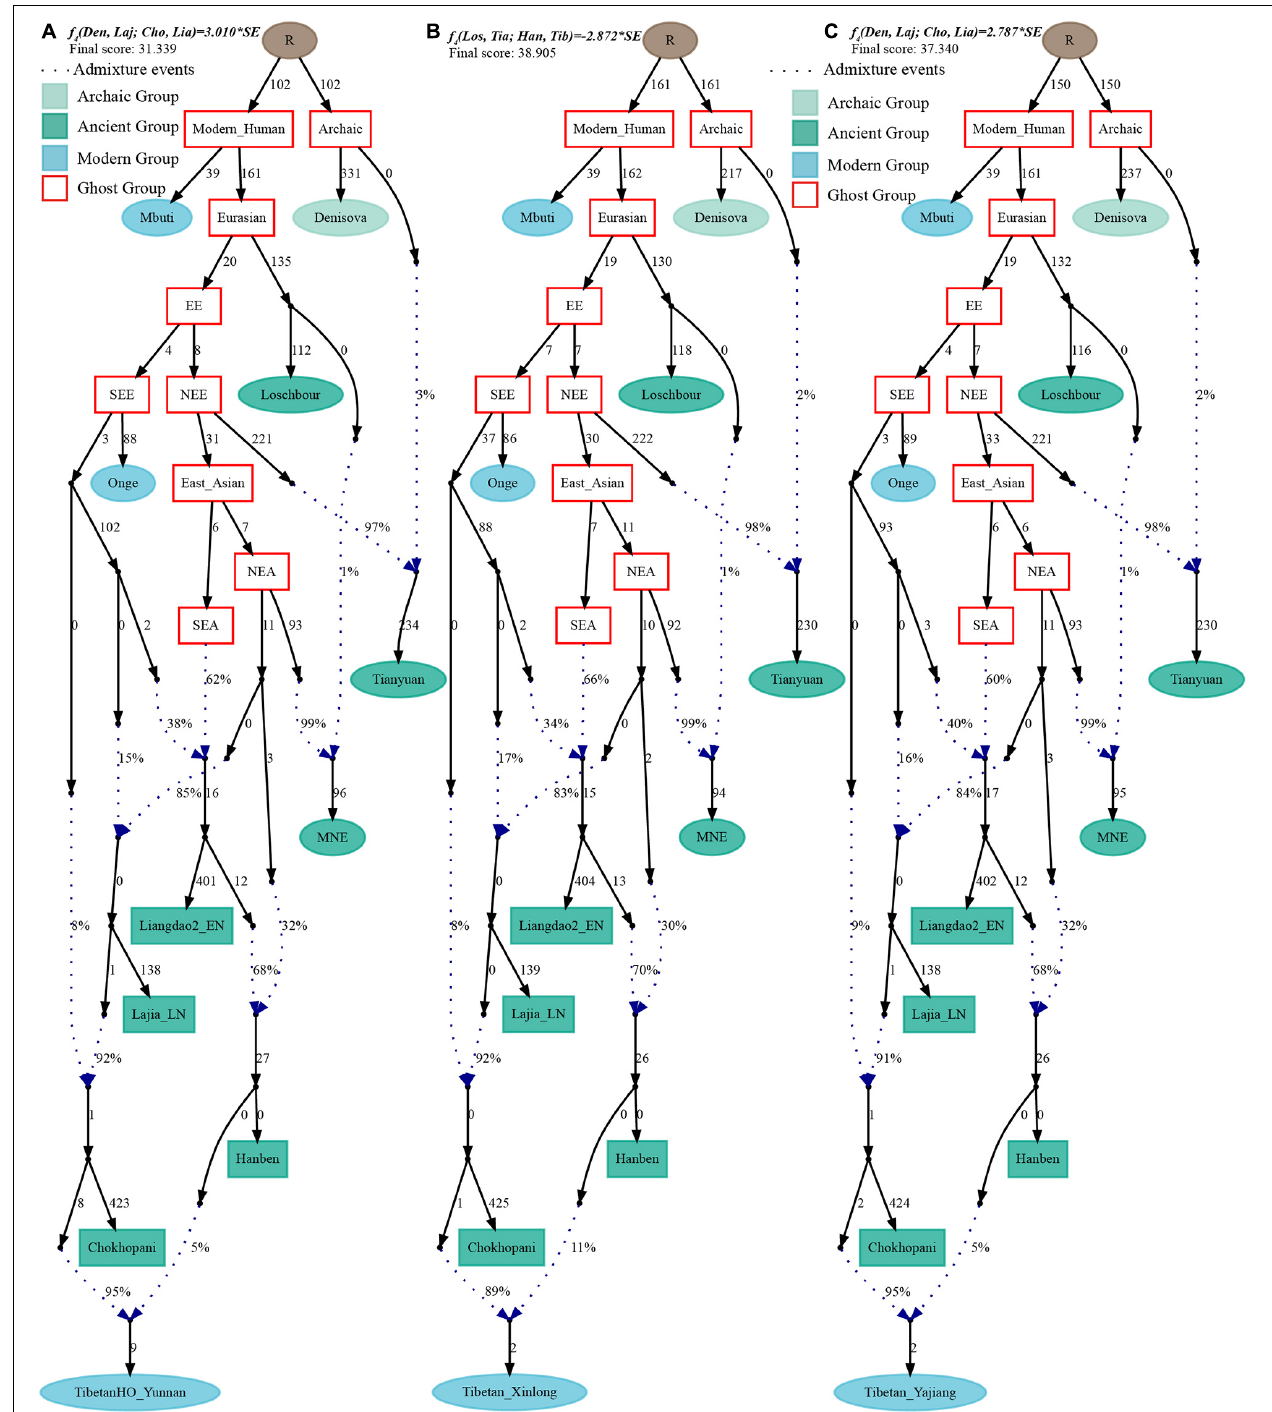
FIGURE 8 | Admixture graph model of East Asians and modern lowland Tibetans based on the Human Origin dataset. Admixture history of lowland Tibetan from Yunnan (A) , Tibetan from Xinlong (B) , and Tibetan from Yajiang (C) .